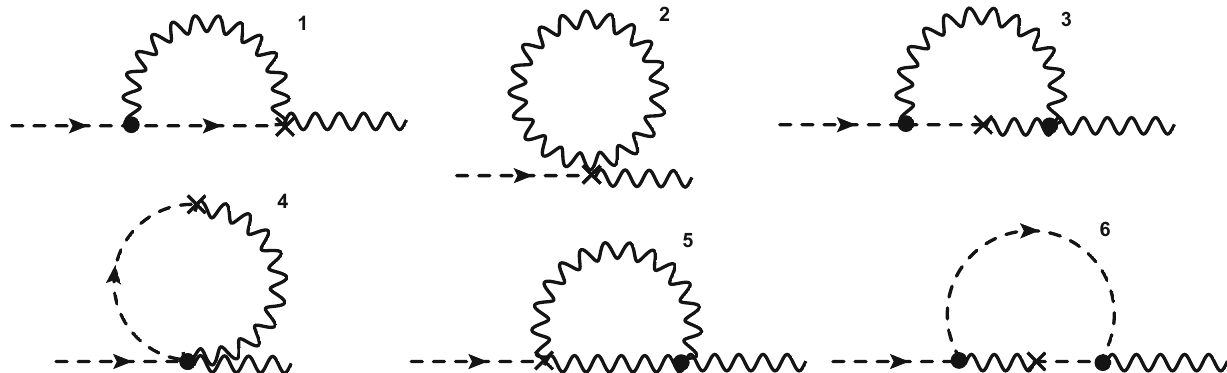
oftheGluino-Glueoperator.Diagrams2,4donotappearindimensional regularization; they do however show up in the lattice